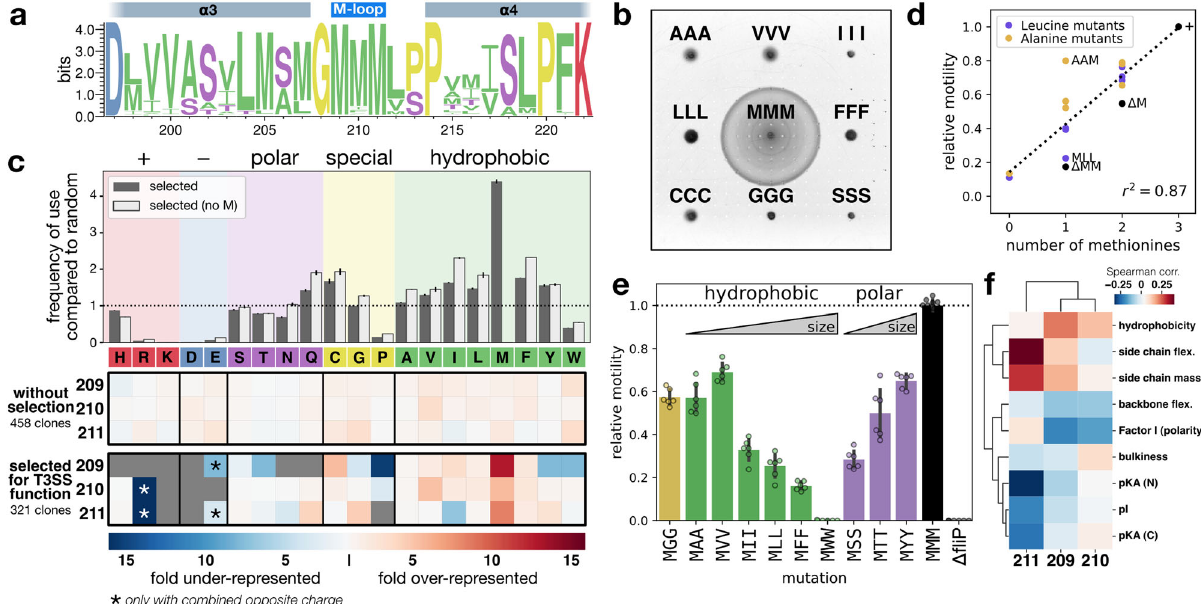
Fig. 3 Methionine residues display a unique combination of physicochemical features that are required for T3SS function. a Unlike the FliR plug, methionine residues in the FliP M-loop are highly conserved. From a selection of about 2500 unique sequences of FliP homologs reported in a previous work 7 , the fi rst and last methionine residues are 99% conserved and the central one 87%. b Motility in soft agar of triple M-loop variants. Unlike single- amino acid substitutions to small and hydrophobic residues that have a limited impact on motility (Fig. 2b), triple substitutions almost completely abrogate fT3SS function. c Amino acid usage bias in a set of random triple variants of the FliP M-loop. Variants selected for fT3SS function displayed a strong bias toward speci fi c residues (hydrophobic residues with a net preference for methionines). The bars above the heatmaps represent the frequency of amino acid usage in the motif upon selection relative to the random group, either considering all motifs (dark gray) or excluding motifs containing at least one methionine (light gray) and error bars the standard deviation of the calculated probability. See Figs. S1c and S3a for a description of the selection methods and Fig. S3b for the corresponding individual results. d Correlation between the number of methionines in the M-loop and the relative motility in soft agar (see Fig. S3e). e Motility in soft agar of various MXX mutants indicates that side chain length of the M-loop residues impacts fl agellar function differently depending on the chemical nature of the side chain. n = 6 biological replicates, except for MMM ( n = 10). The bars represent the mean value of the individual measurements and the error bars the standard deviation. f Position-speci fi c correlation between fT3SS function (motility score) and the physicochemical features of the M-loop residues. Side chain fl exibility, amino acid-size, and hydrophobicity are positively correlated with fT3SS function. In contrast, bulkiness, side chain polarity, and backbone fl exibility display a negative correlation. Experiments were performed with at least three biological